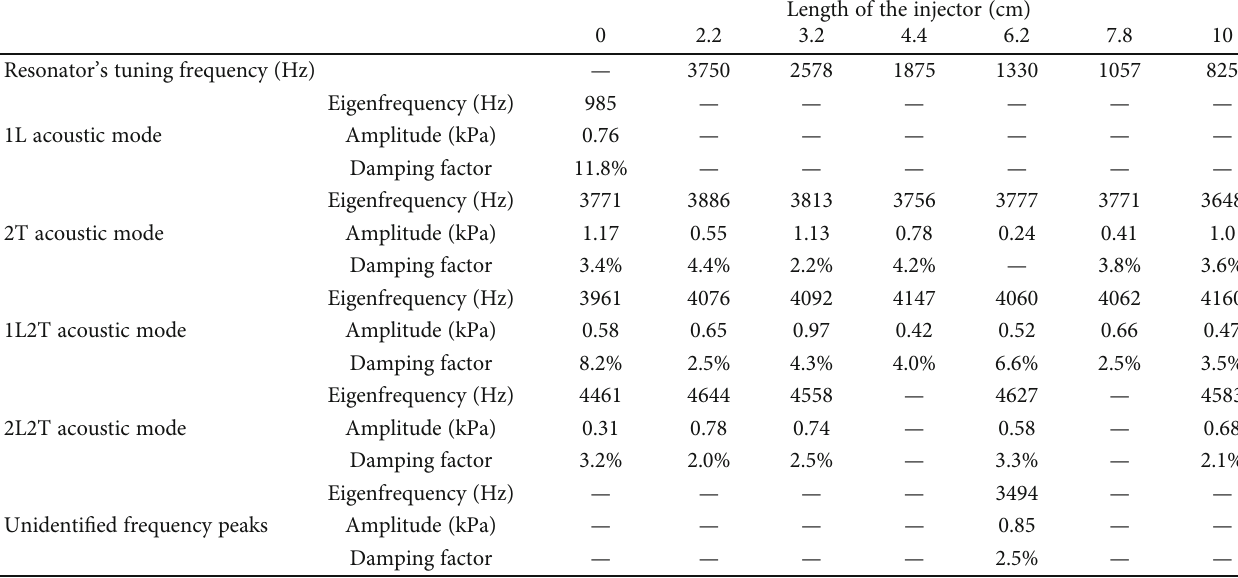
Length of the injector